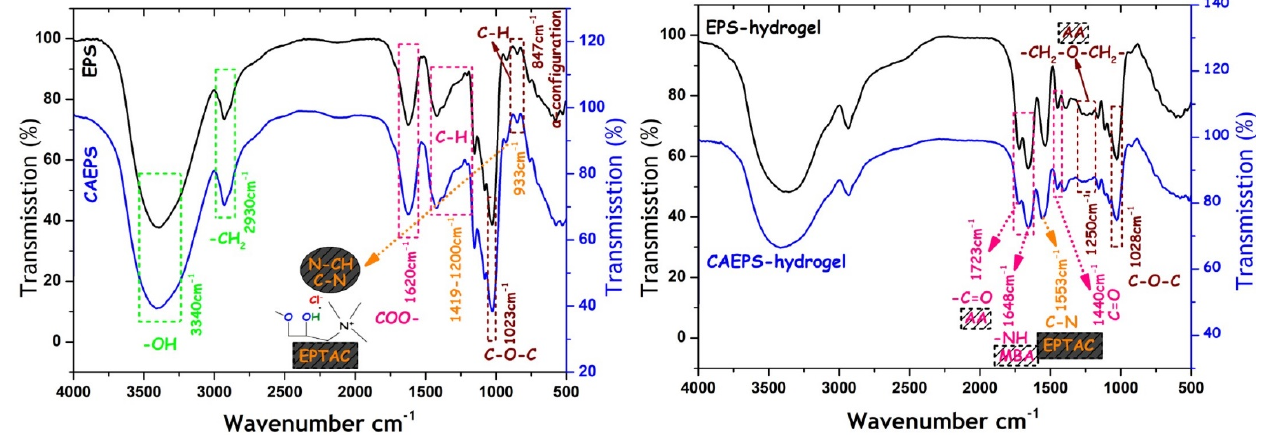
Figure 3. FT-IR spectra of EPS, CAEPS, EPS-, and CAEPS-hydrogel. 2.1.4. TG